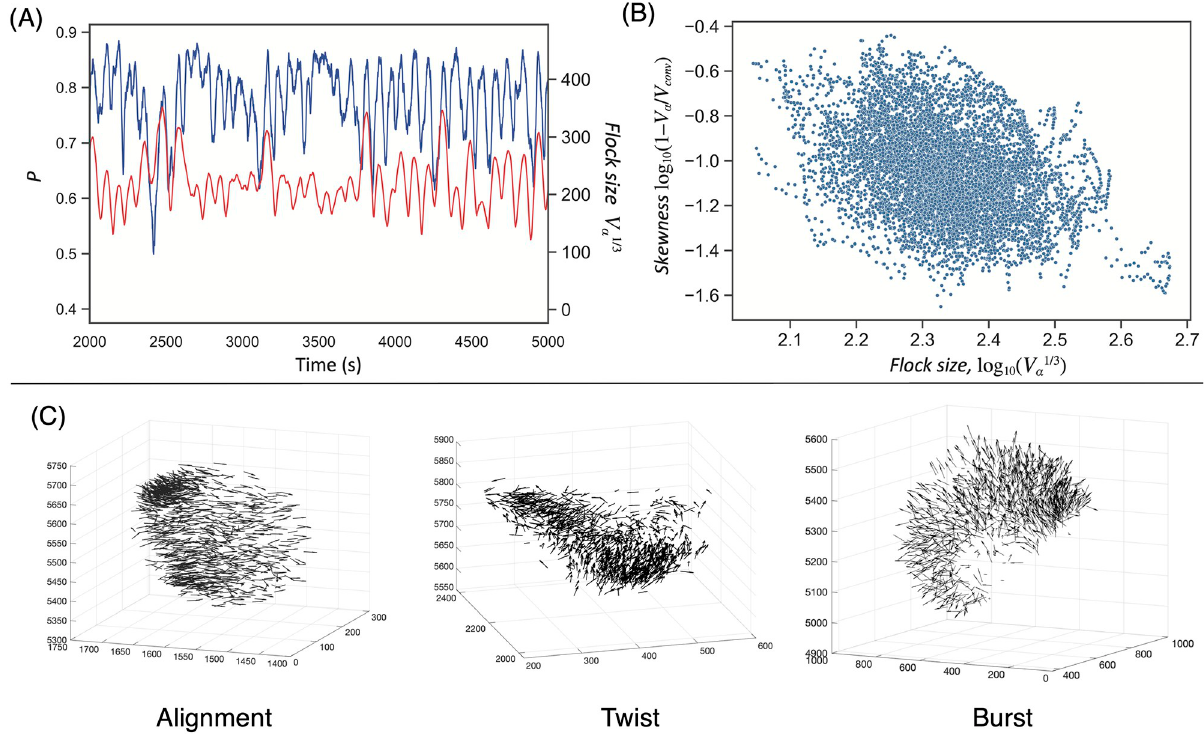
P ^ v j = N and flock size V 1 3 a . (B) The negative correlation between V 1 3 a and its i i 2 N